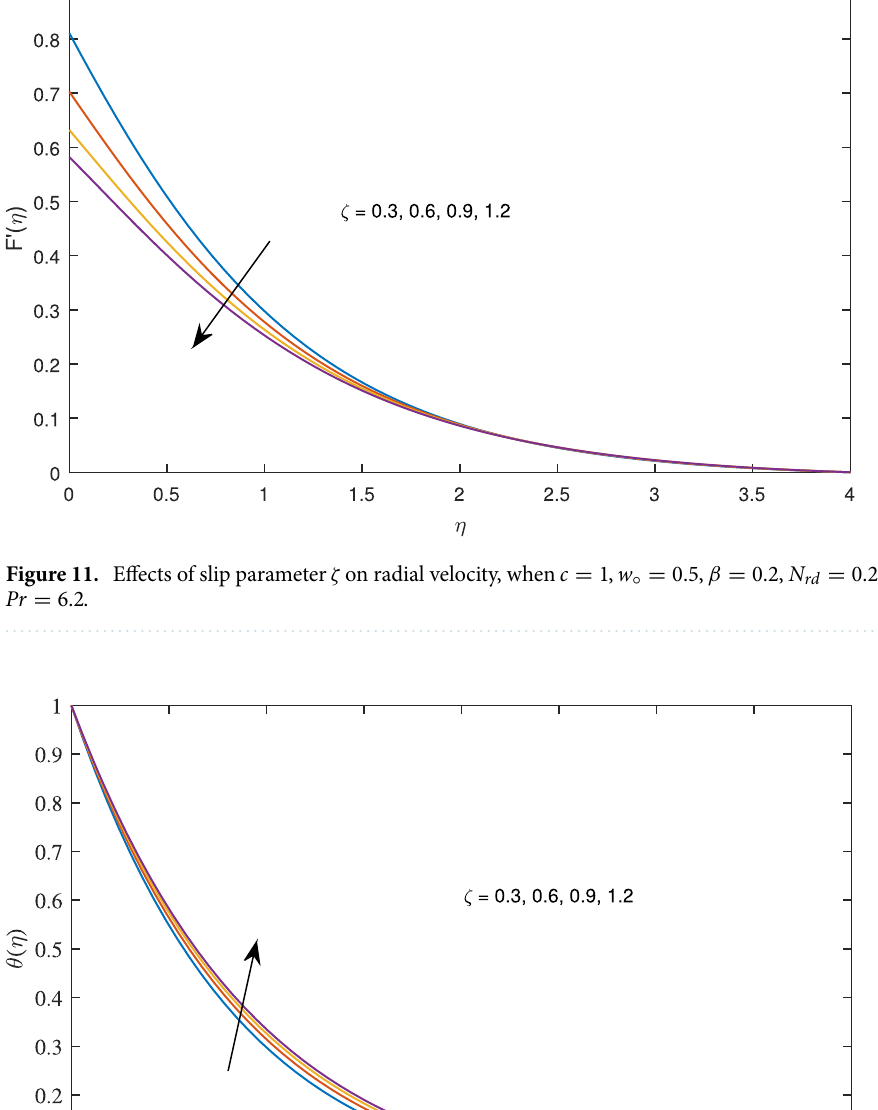
1 , w 0.1 0.5 , β 0.2 , N 0.2 , φ rd = = = = ◦ =